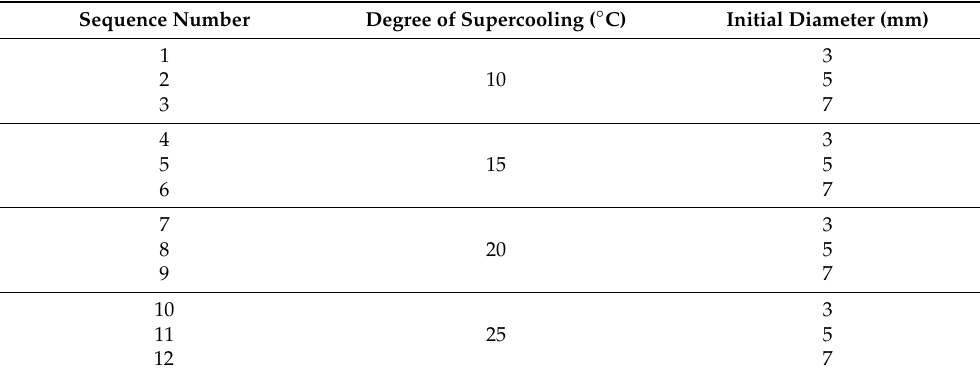
Table 1. The condition of simulation.